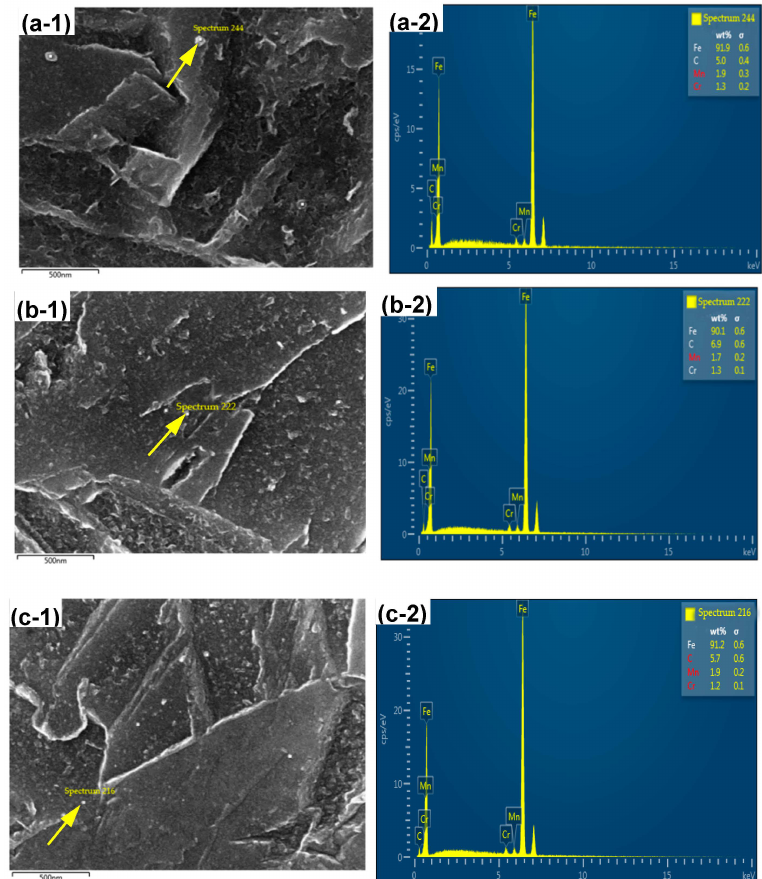
Figure 10. SEM and EDS of second-phase particles for hot-formed parts in different positions: ( a-1 , 2 ) top; ( b-1 , 2 ) side; and ( c-1 , 2 )